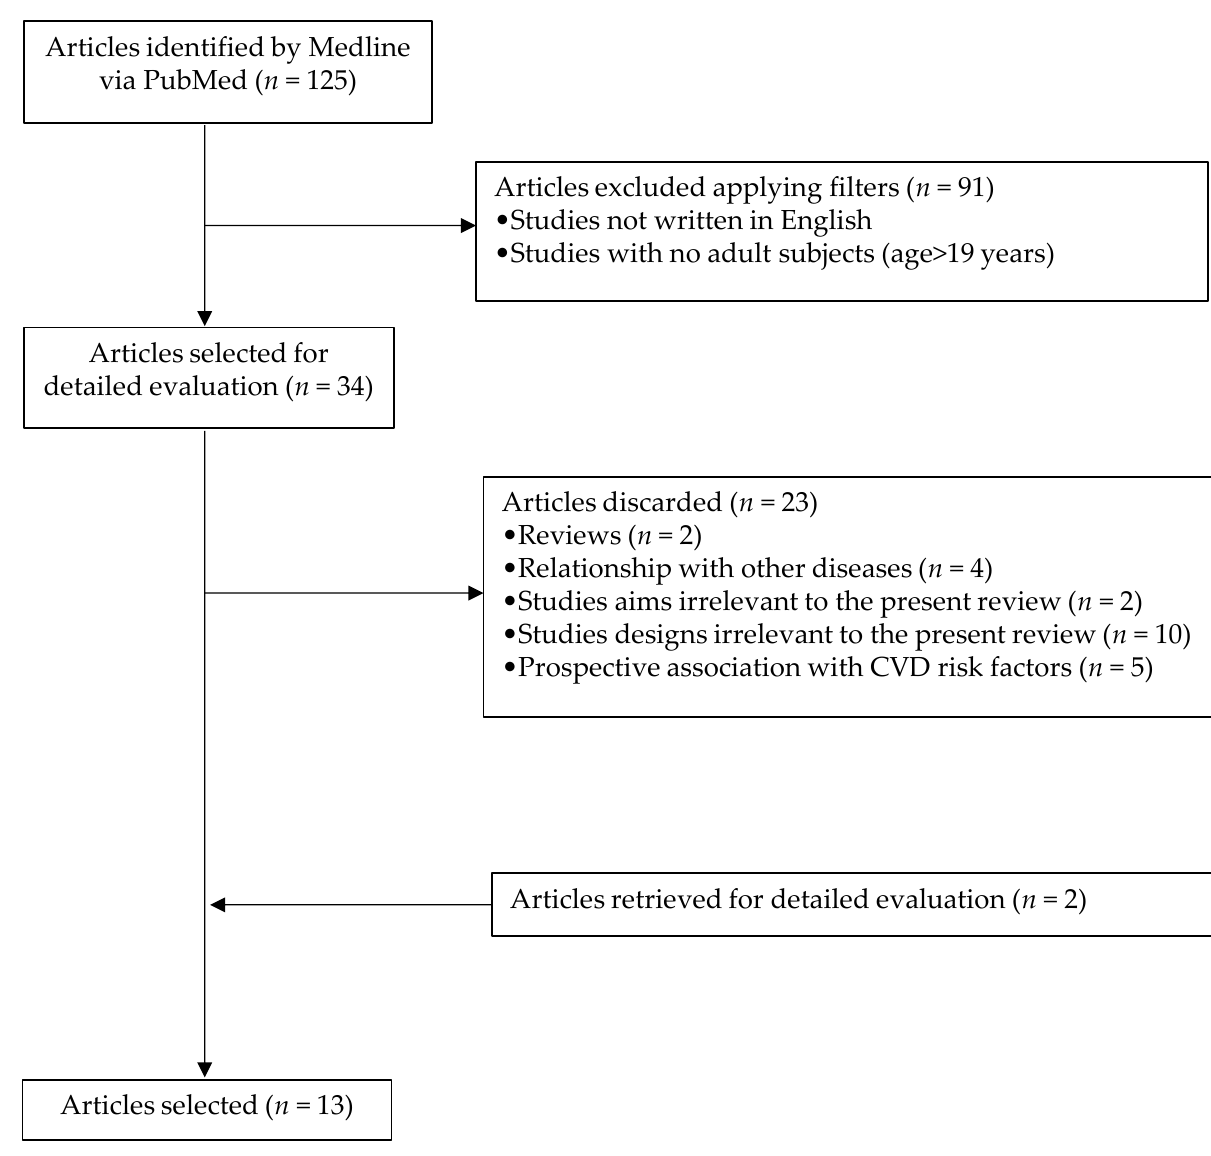
Figure 1. Flowchart highlighting the selection process of articles.